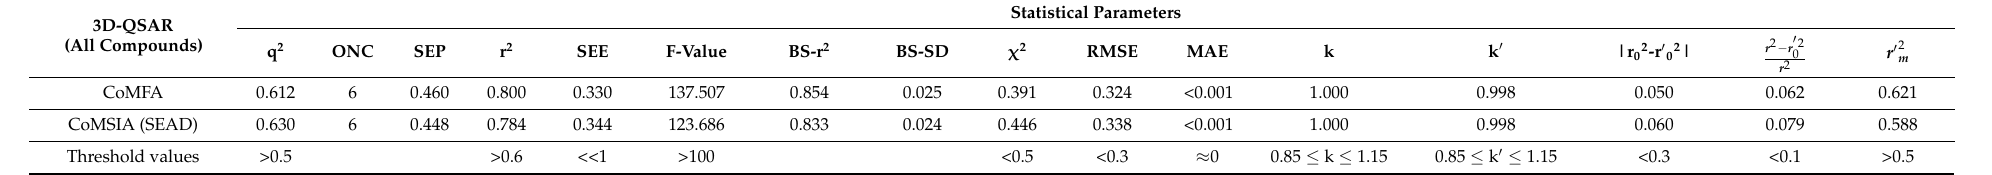
Table 6. Statistics of the CoMFA and CoMSIA models by including all compounds from the dataset of PI3K γ .